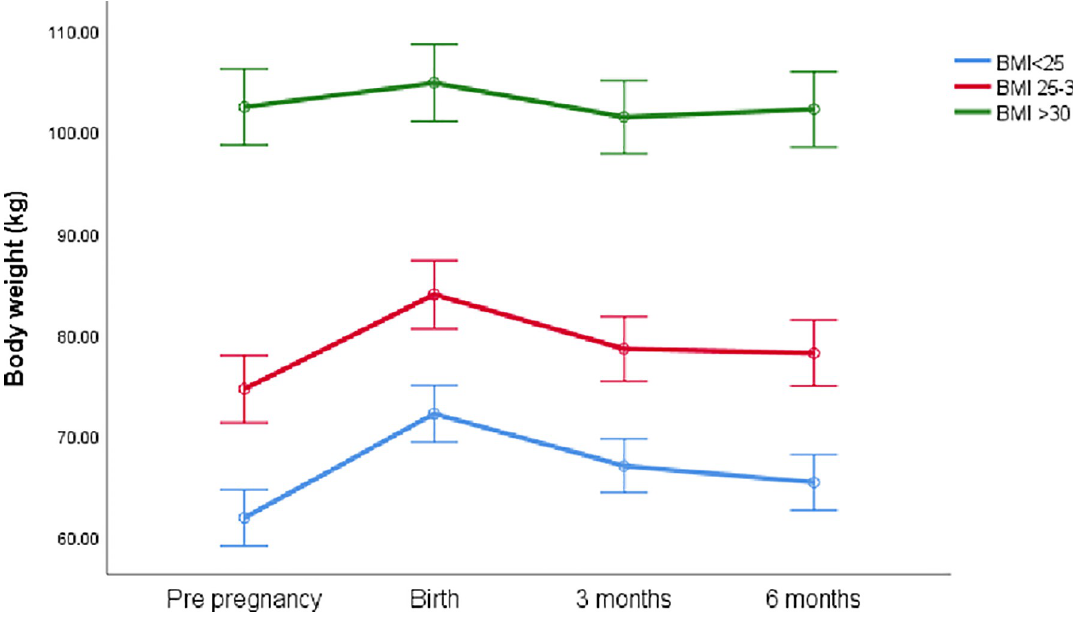
Fig 1. Pre- and post-partum BW of mothers from different BMI categories (mean ± SD).